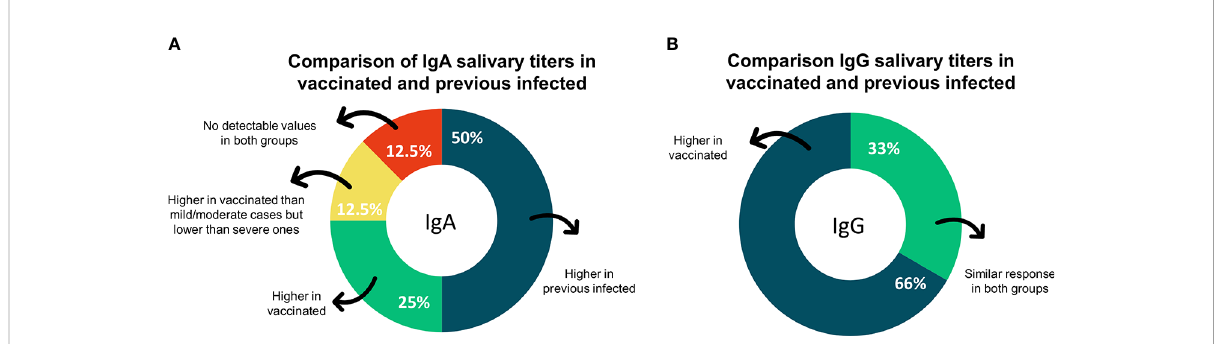
FIGURE 4 The proportion of studies on secondary outcomes. (A) Graphic showing the proportion of studies reporting results on IgA comparison between vaccinated and previous infected individuals (B) Graphic showing the proportion of studies reporting results on IgG comparison between vaccinated and previous infected individuals. IgA, immunoglobulin A; IgG, Immunoglobulin